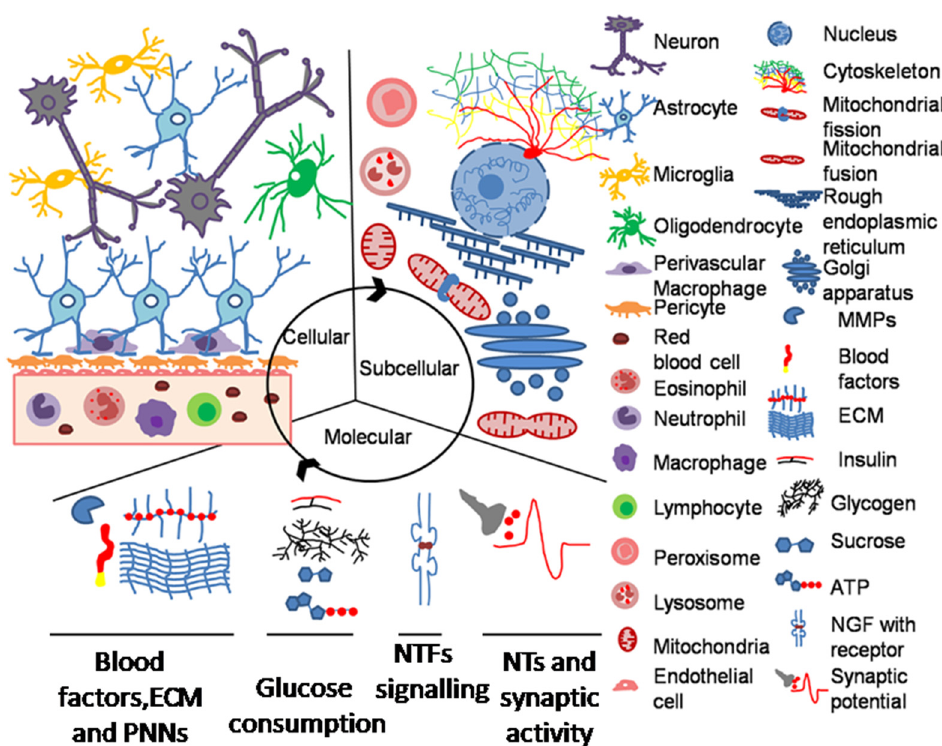
Figure 3. Cellular, subcellular, and main molecular components to be considered in synaptic plas- ticity modeling on a spatiotemporal concurrency. ECM, extracellular matrix; PNN, perineuronal nets; NTFs, neurotrophins; NTs, neurotransmitters.